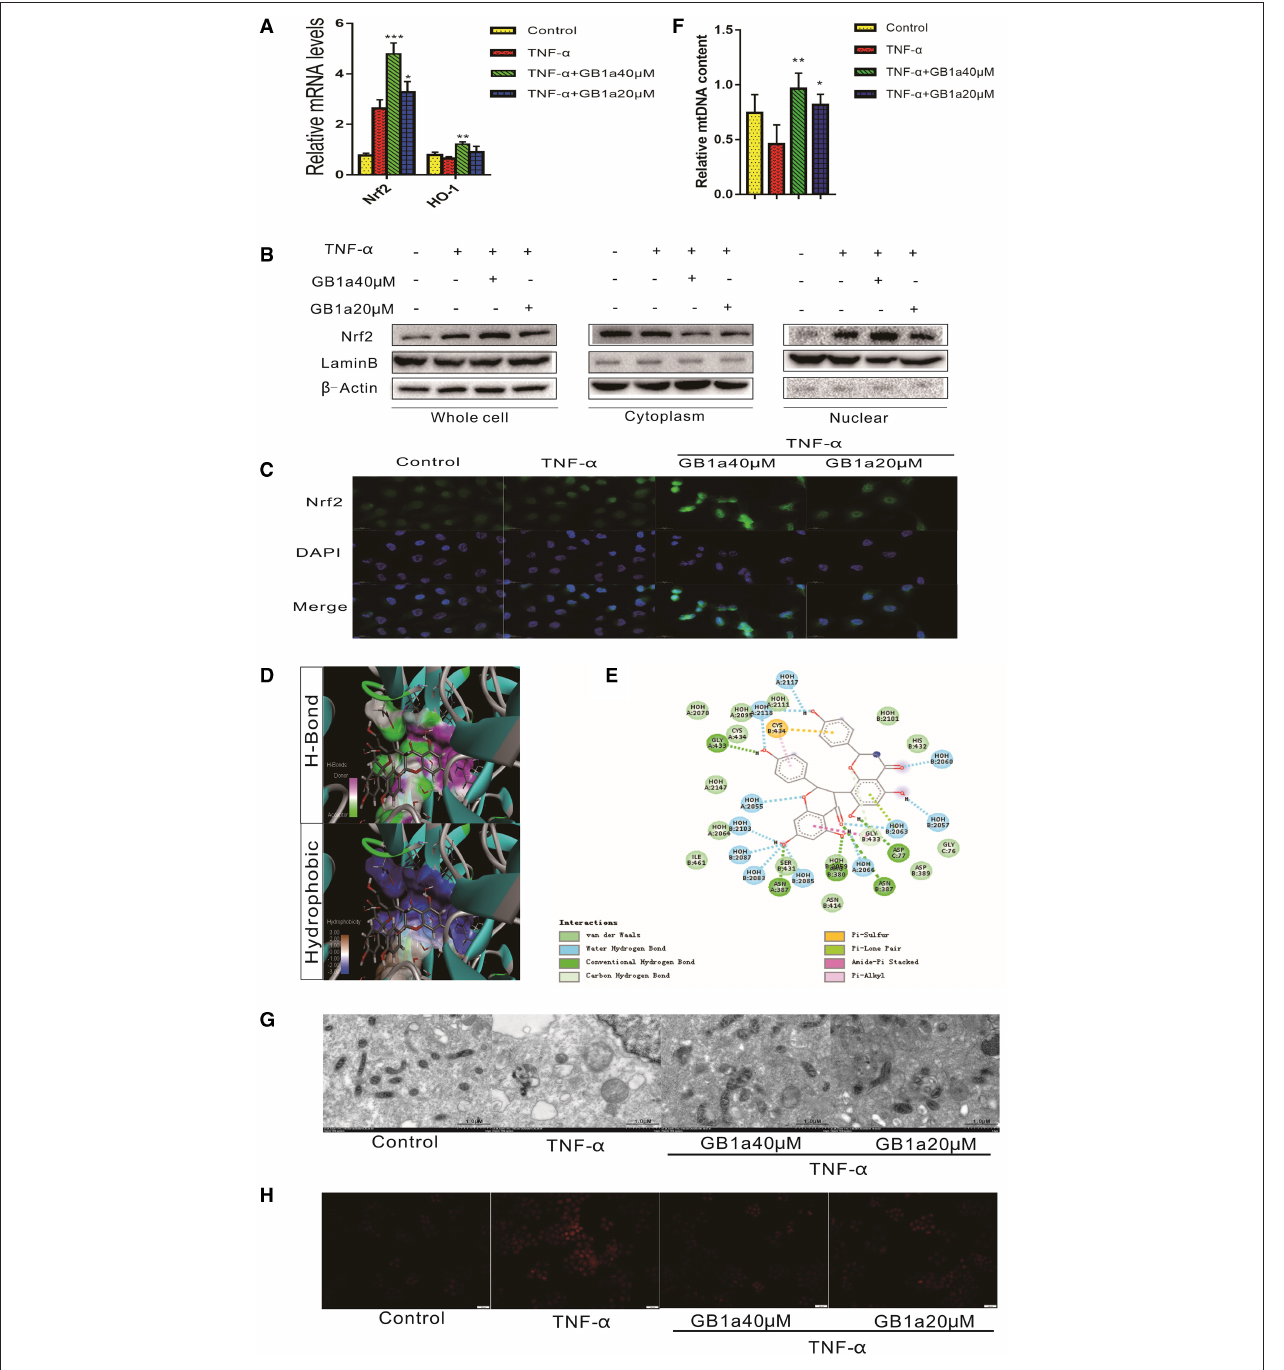
FIGURE 2 | GB1a activates the Nrf2 pathway and alleviates TNF- α -induced mitochondrial injury in vitro. (A) GB1a treatment upregulated the expression of Nrf2 and HO-1. (B) Western blotting results showed that GB1a advances Nrf2 translocation to the nucleus and promotes Nrf2 protein expression in the nucleus. (C) Immunofluorescence analysis of Nrf2 (green) in HCoEpic. DAPI was used for nuclear staining (blue). (D) The 2D structure of the predicted binding of GB1a to Nrf2. (E) The molecular docking model of GB1a and Nrf2. (F,G) GB1a treatment improved mitochondrial biogenesis (F) and morphology (G) in HCoEpic. (H) GB1a reduced the levels of ROS in TNF- α -incubated HCoEpic. Data are presented as means ± SD ( n = 5/group). * p < 0.05, ** p < 0.01, and *** p < 0.001 vs. the TNF- α -incubated group.